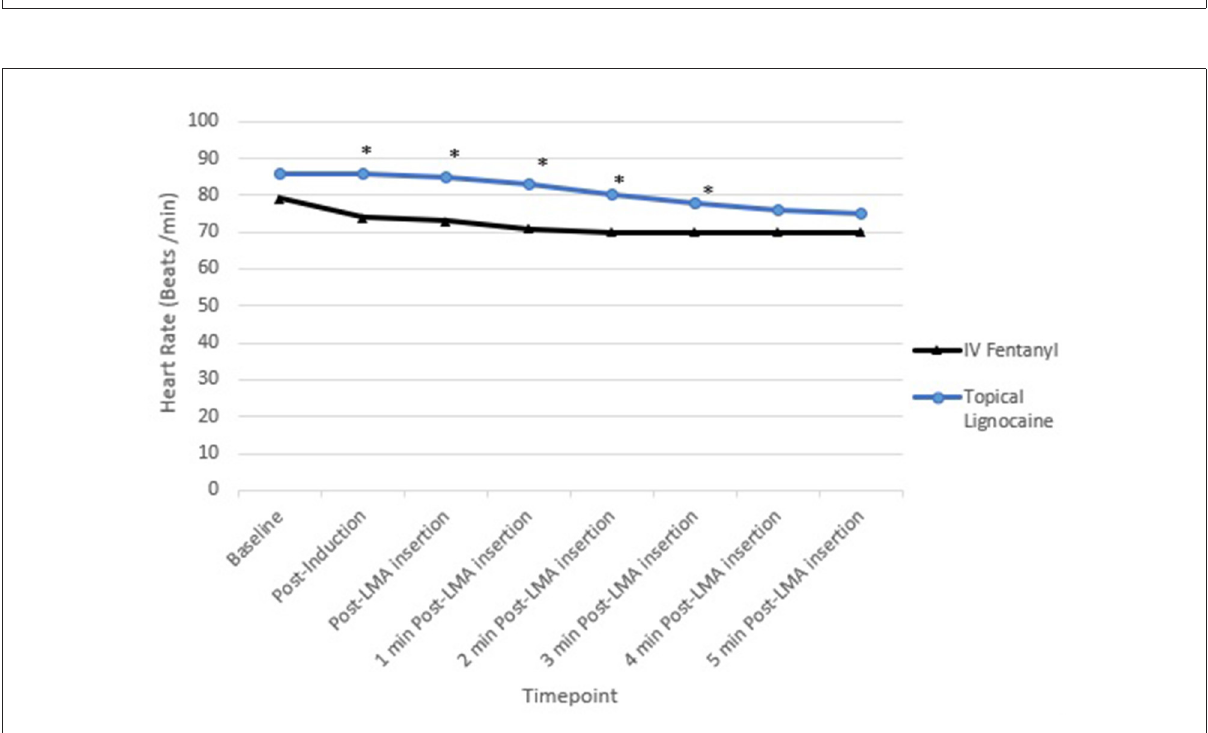
FIGURE4 Mean heart rate (HR). * P <